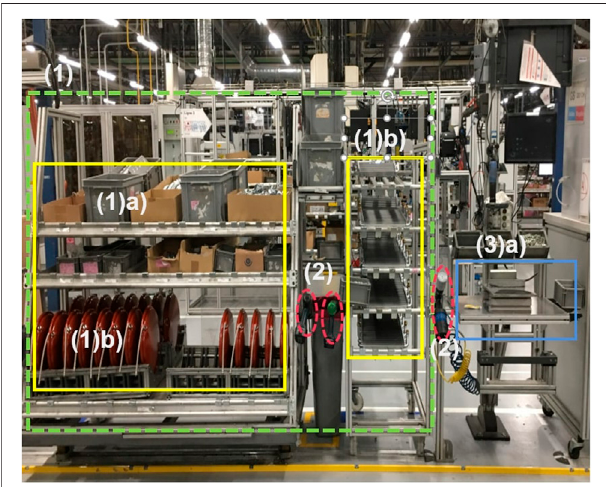
FIGURE 3 | Visualization of the interaction zones of a boiler assembly workstation in an elm.leblanc factory.